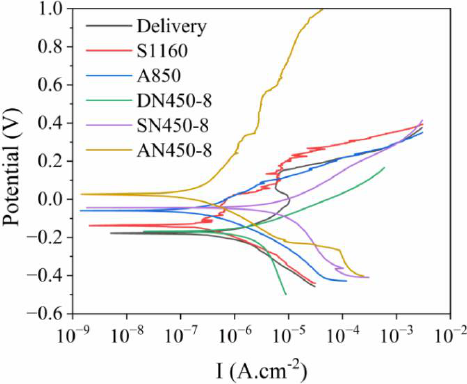
Figure 8. Corrosion polarization curves of AISI 430 ferritic stainless steel before and after low-temperature plasma nitriding. Table 5. Corrosion potential and corrosion current density of AISI 430 stainless steel before and after plasma nitriding.